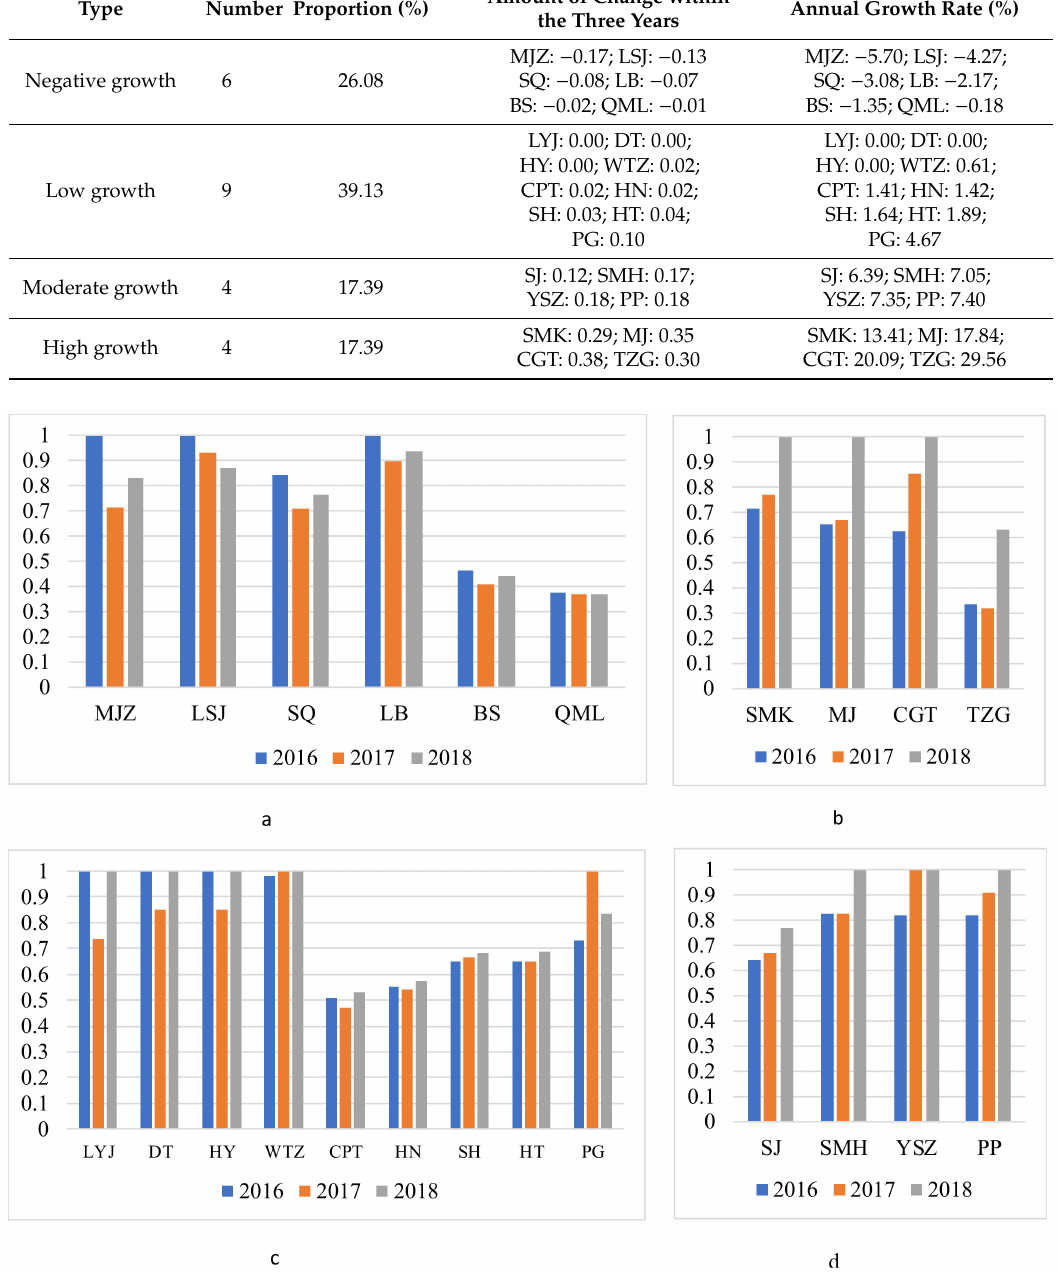
Figure 3. Temporal pattern of the agricultural eco-e ffi ciency. ( a ) Villages of negative growth; ( b ) Villages of high growth; ( c ) Villages of low growth; ( d ) Villages of moderate